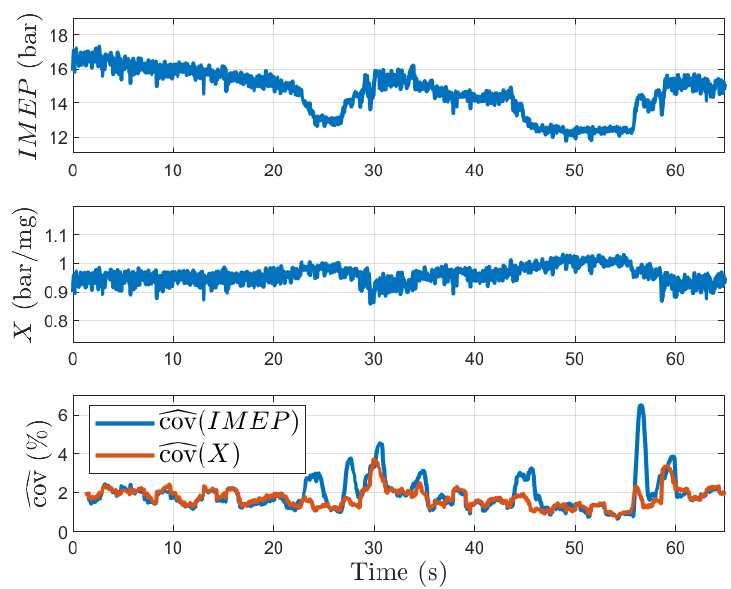
Figure 3. Portion of WLTP cycle. Top plot: IMEP , middle plot: X defined Equation (2), bottom plot: cov estimators. A clear bias of the first stability estimator can be seen during transient (cid:100)